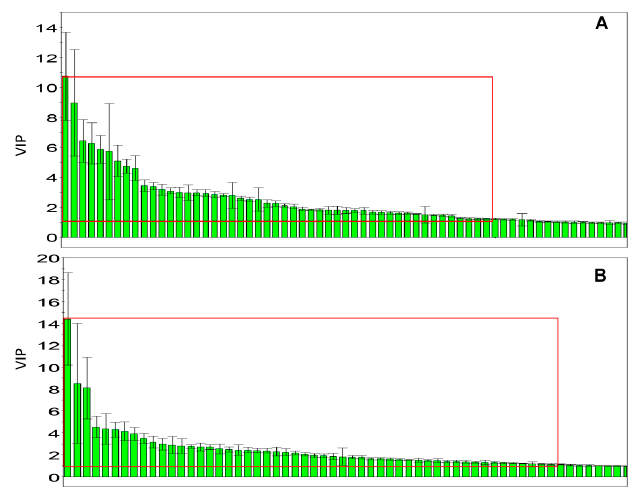
Figure 6. Variable importance projection plots for the serum metabolites along the component. ( A ) Control vs. the CCl 4 model group using PLS-DA; ( B ) JGG vs. the CCl 4 model group using PLS-DA.